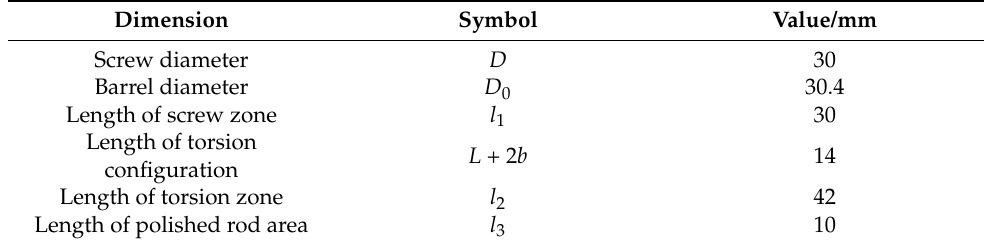
Figure 2. The simulation object-torsion screw. Table 1. Basic physical parameters of the